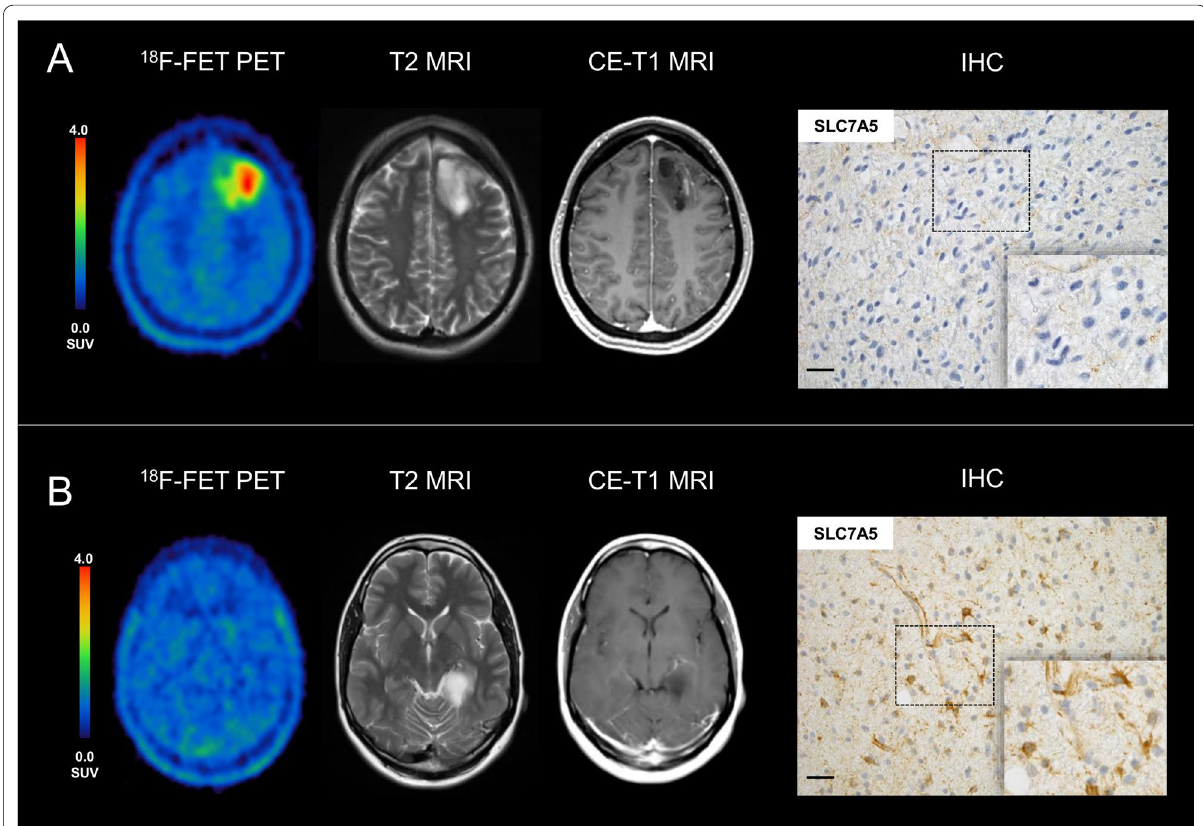
Fig. 1 Patient example with a A 18 F‑FET‑positive, WHO grade II glioma with a high 18 F‑FET‑uptake (TBR max 4.36) and small nodular contrast enhancement on MRI but with very low LAT1 tumour cell expression (H‑score 9.0) and slightly positive vessels in the SLC7A5 immunohistochemical (IHC) staining in contrast to a B 18 F‑FET‑negative, WHO grade II glioma (TBR max 1.27) with T2 alterations and missing contrast enhancement on MRI but a very high LAT1 expression (H‑score 102.0) and intensive vessel